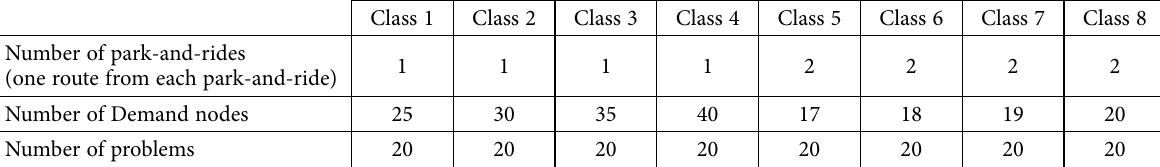
Fig. 3. Schematic illustration of crossover Fig. 4. Mutation operators of the GA-based approach Table 1. Key parameters of the sample